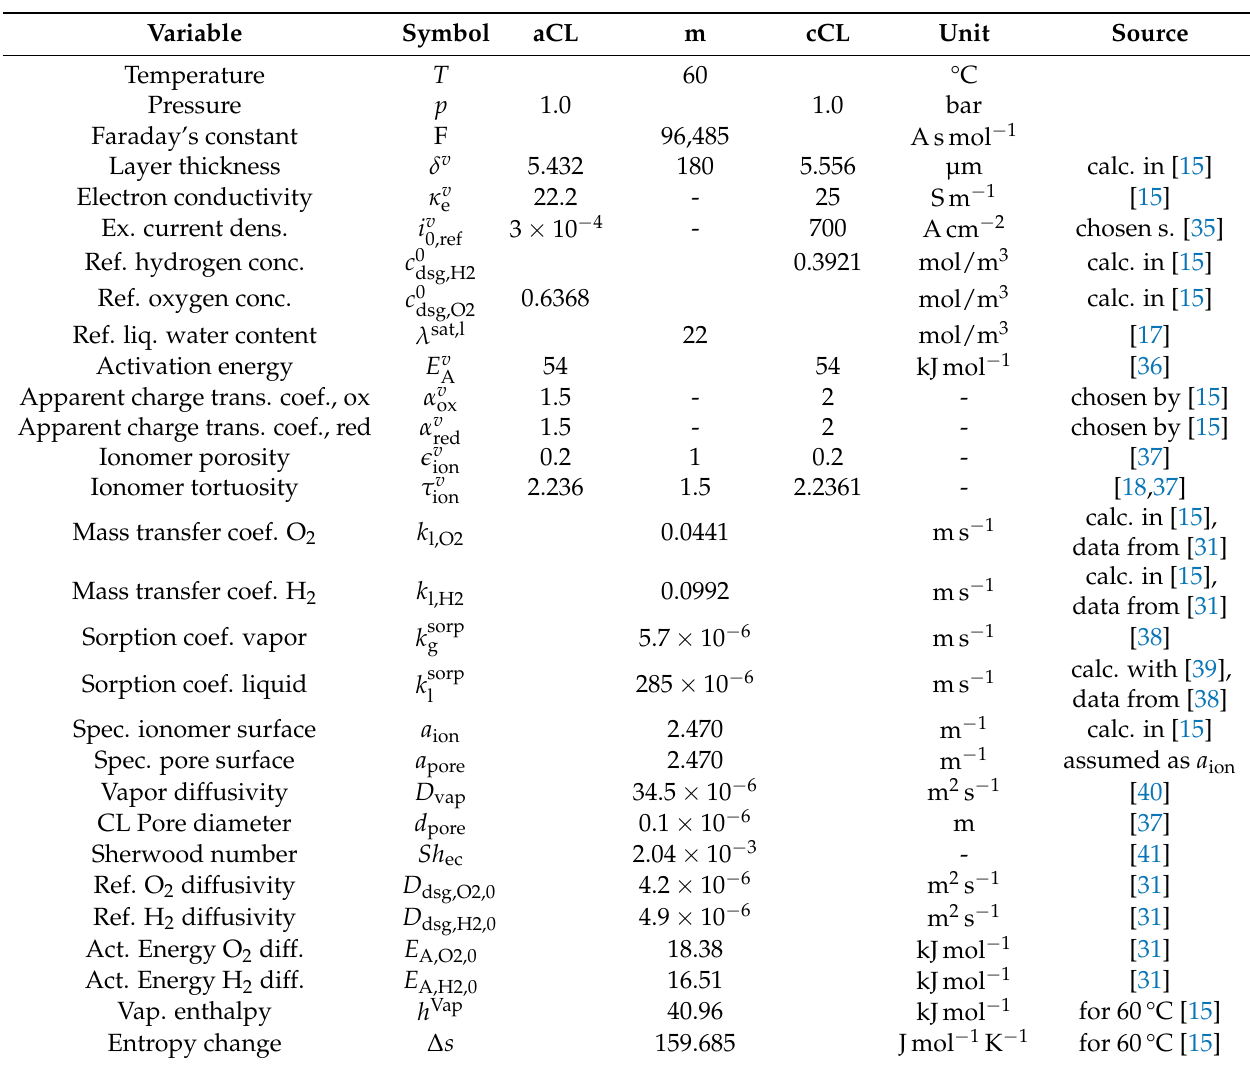
Table A3. Chosen parameters and